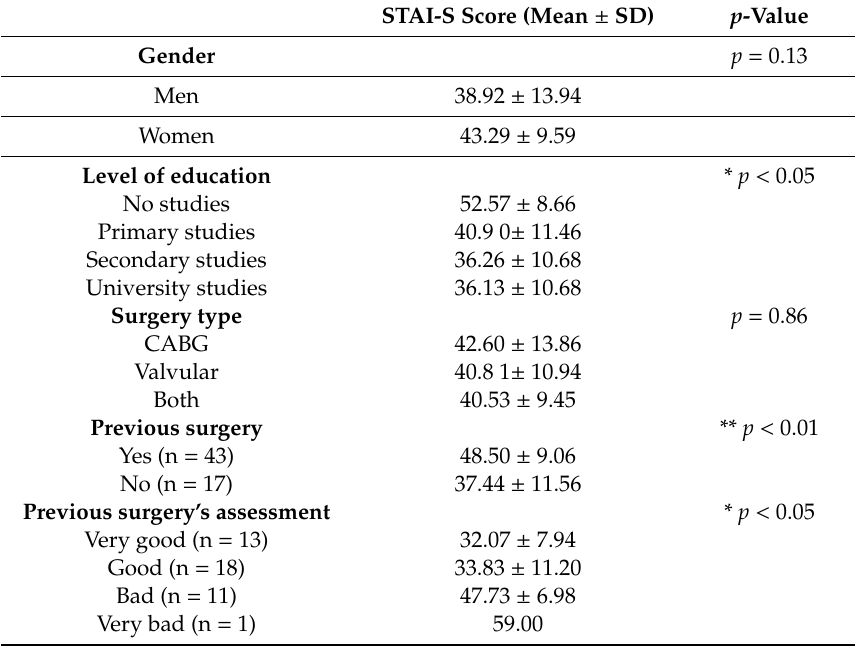
Table 2. Anxiety scores according to descriptive features of the studied population.